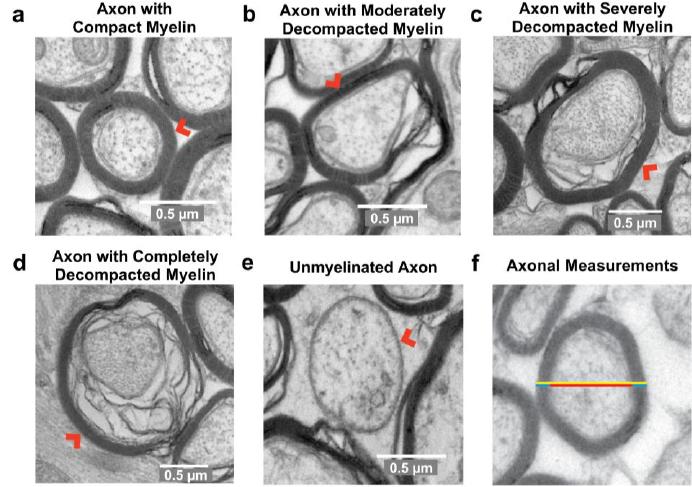
Figure 2. Representative images of axon cross-sections classified based on myelin compaction. Axons with compact myelin were characterized by thick, high electron density (dark appearance) myelin with <10% axon circumference affected by decompaction ( a ). Axons with moderately decompacted myelin had 10–35% of the axon circumference affected by decompaction ( b ). Axons with severely decompacted myelin had 35–99% of the axon circumference affected by decompaction ( c ). Axons with completely decompacted myelin were characterized by decompacted myelin surrounding the entire axon circumference ( d ). Unmyelinated axons had a round or oval appearance with no surrounding myelin ( e ). Depiction of axonal morphology measurements. Axon diameter was measured at the minimum distance (red); myelin thickness was measured at the same location, parallel to the diameter measurement and presented as an average of the 2 sides (blue); fiber diameter was measured at the same location, parallel to axon diameter and included myelin, axon, and axolemmal space if present (yellow) ( f ). Red arrows indicate representative axon. Scale bars = 0.5 µm.